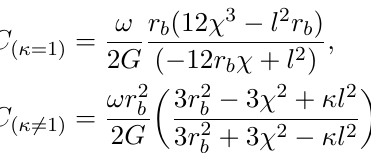
Figure 3 . Heat Capacity (2.39) vs. NUT charge for uncharged TB-AdS for κ = 1 and G = l = 1 .